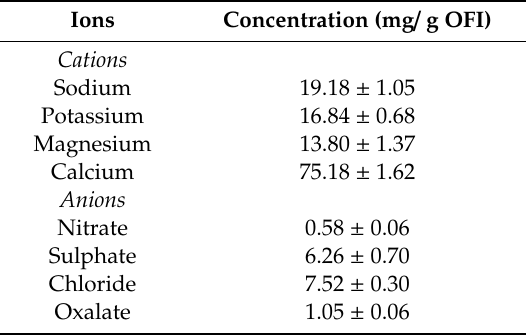
Table 3. Anion and cation compositions in Opuntia ficus indica cladodes (OFI).